Question: What direction does the quantity move in — increasing or decreasing?
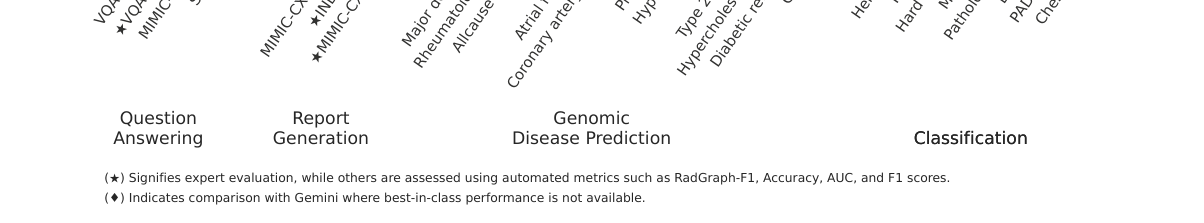
Answer: increasing